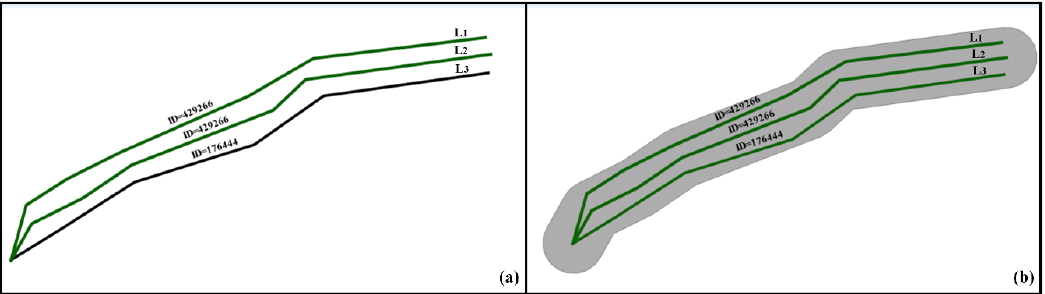
Figure 13. An example of identifying the corresponding objects: ( a ) using the ID in the history file; and ( b ) calculating the common buffer area.